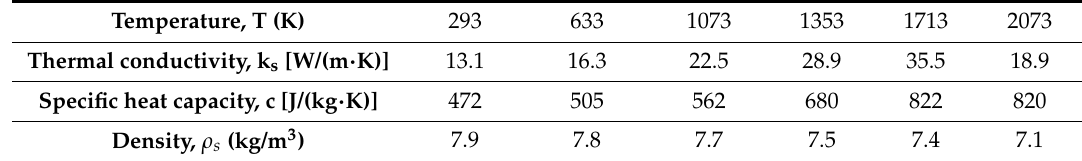
Table 2. Thermo-physical parameters of 316L SS [26,27].